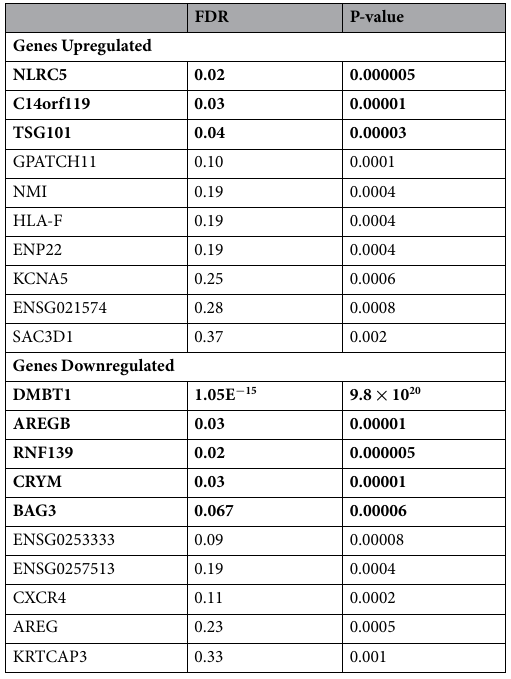
Table 1. pDC gene expression summary. Genes in bold have a False Detection Rate (FDR) <